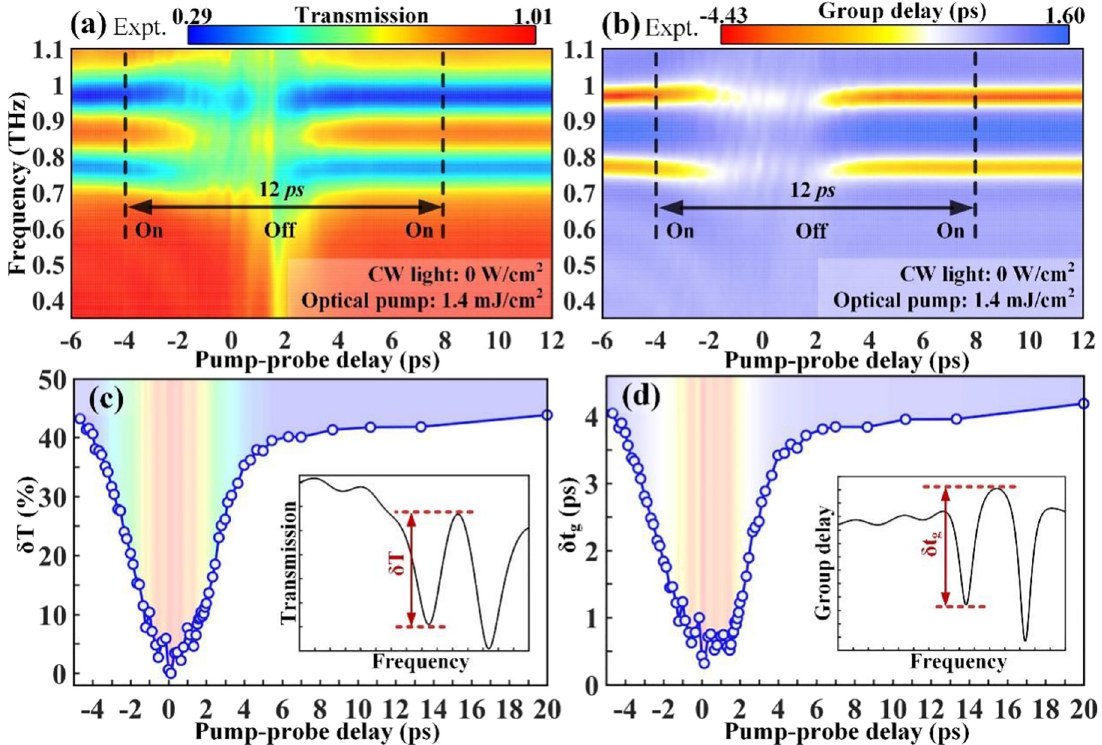
Figure 4: Experimental results of ultrafast and efficient photo-switching of THz wave at the original EIT resonance frequency of 0.86 THz. Monitored THz dispersion spectrum that is mapped as a function of the pump – probe time delay for (a) transmission amplitude and (b) group delay. (c) EIT resonance amplitude and (d) group delay amplitude versus the probe time delay showing transient modulation dynamics within one switching cycle. Here, the device is under no CW light illumination and the pump fl uence remains a constant of 1.4 mJ/cm 2